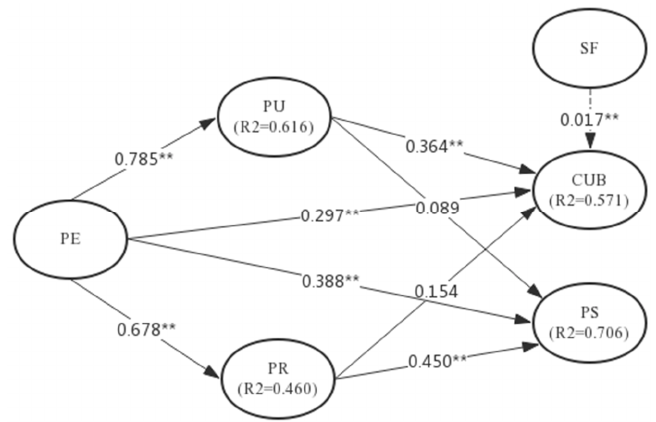
Figure 2. Model Results. Path coefficients with t-values in parentheses, ** p < 0.01. Table 4. Structural parameter estimates.